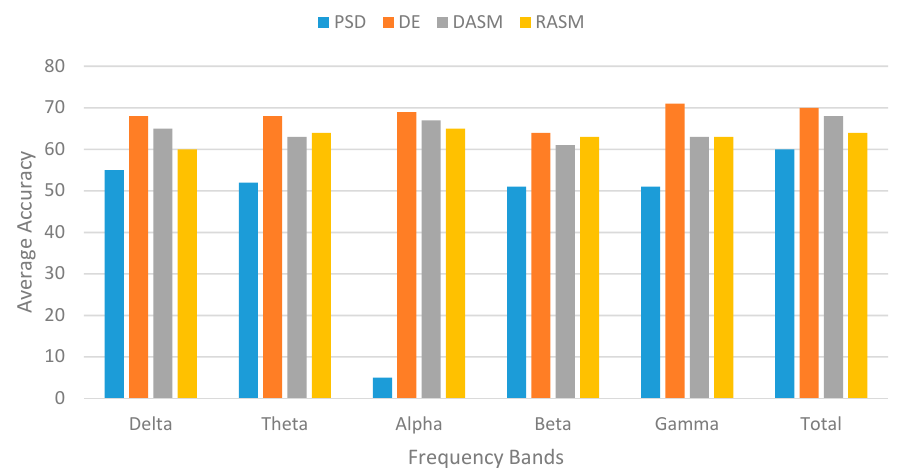
Figure 15. Average accuracy of the classifier using different features on different frequency bands.